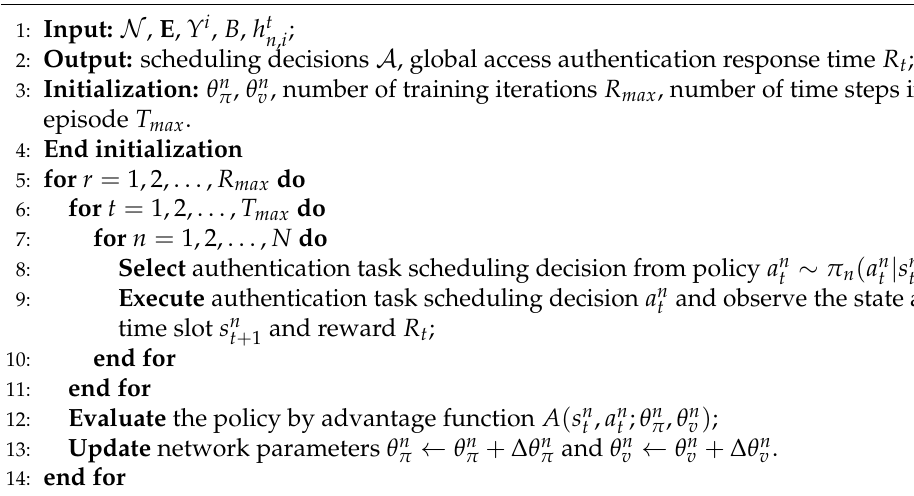
Algorithm 1 A2C-based Task Scheduling